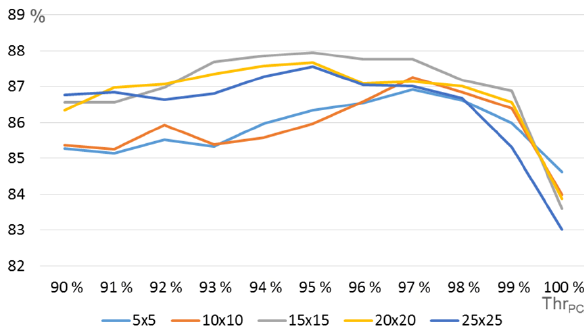
Figure 5. Comparisons of detection accuracy using different classi- fiers with single pixel color information.